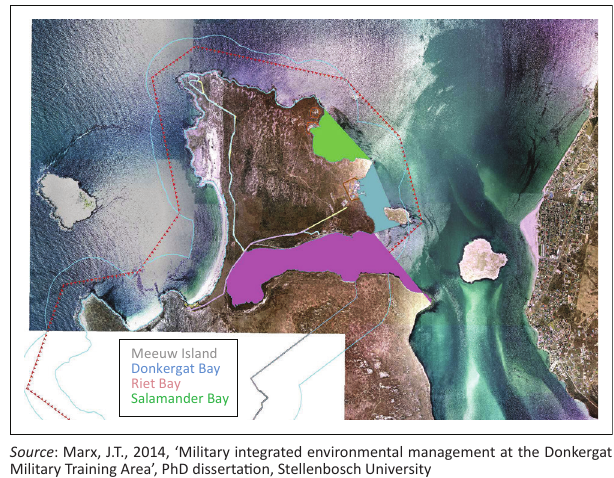
FIGURE 7: Proposed localities to be included in the Langebaan Ramsar